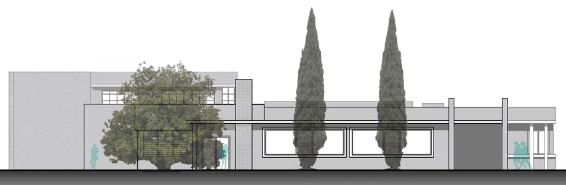
Figure 11: Facade drawing made upon the image Figure 8: Po int clo ud made with the photogrammetry obtained data.